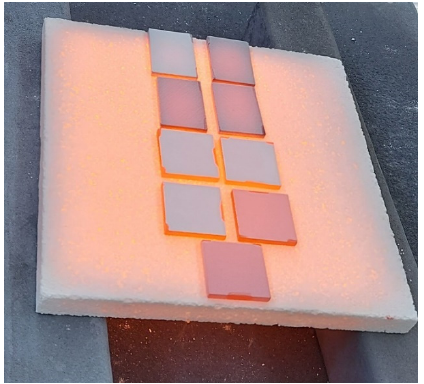
Figure 7. Different samples after beginning of the cooling down from the first cycle (1300 °C, 20 h), left to right and top to bottom the samples are HVAPS1, APS1, APS2*, APS2, HVAPS1, HVAPS2, HVAPS3, APS1, APS2. * indicates slightly reduced feeding rate.